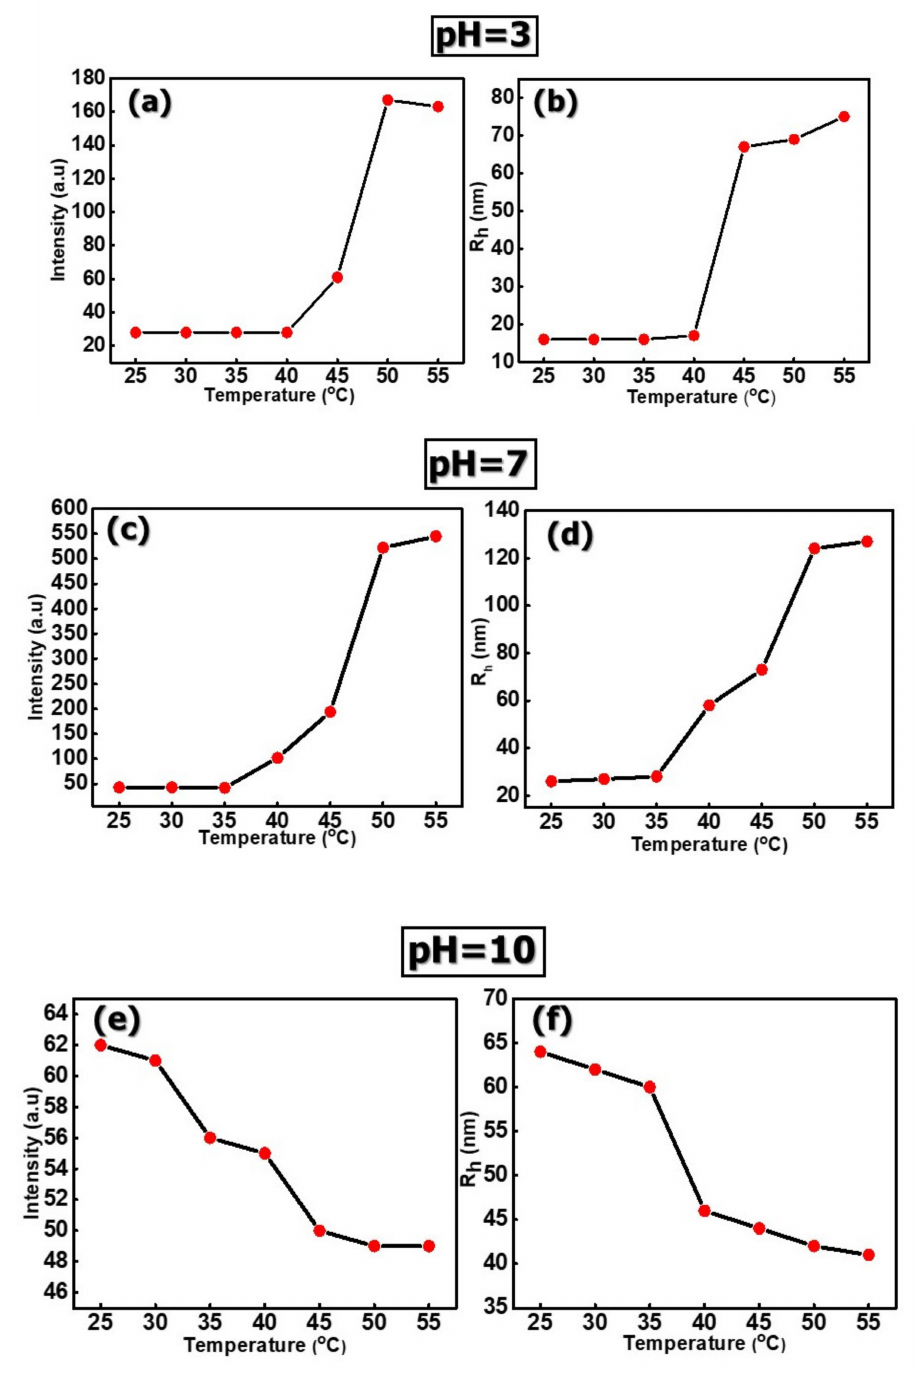
Figure 3. The dependence of scattering intensity and R h on temperature at pH = 3 ( a , b ), pH = 7 ( c , d ), and pH = 10 ( e , f ) for the PDMAEA 20 -b-PNIPAM 11 -POEGA 18 triblock terpolymer in aqueous media (at an angle of 90 ◦